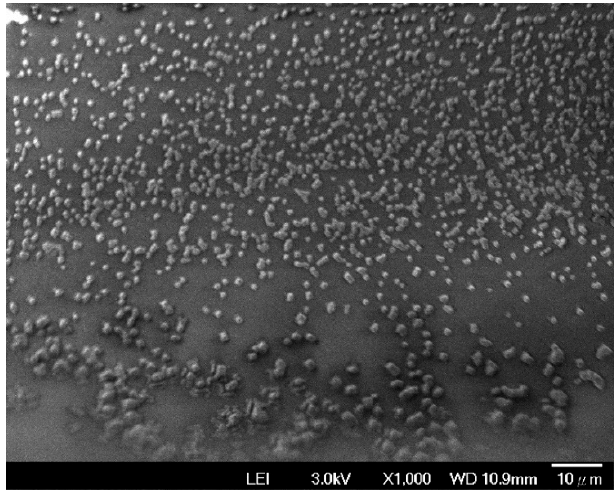
Figure 7. FE-SEM image of the SPCE coated with the mixture of ZnO nanoparticles and